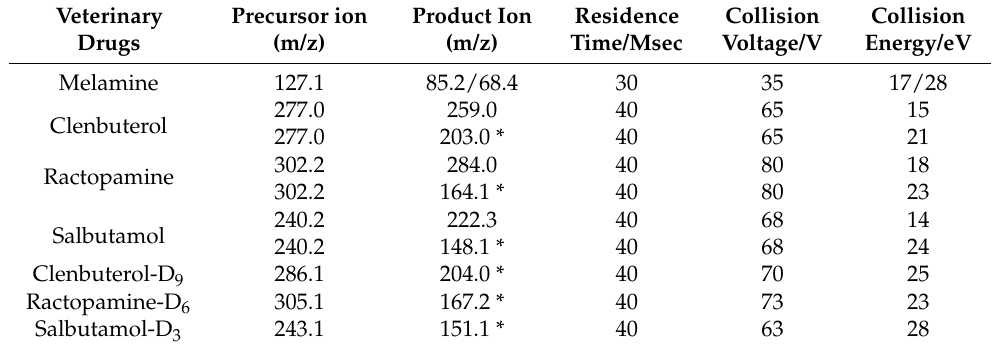
Table 1. Tandem mass spectrometry detection parameters of melamine and three β-agonists.